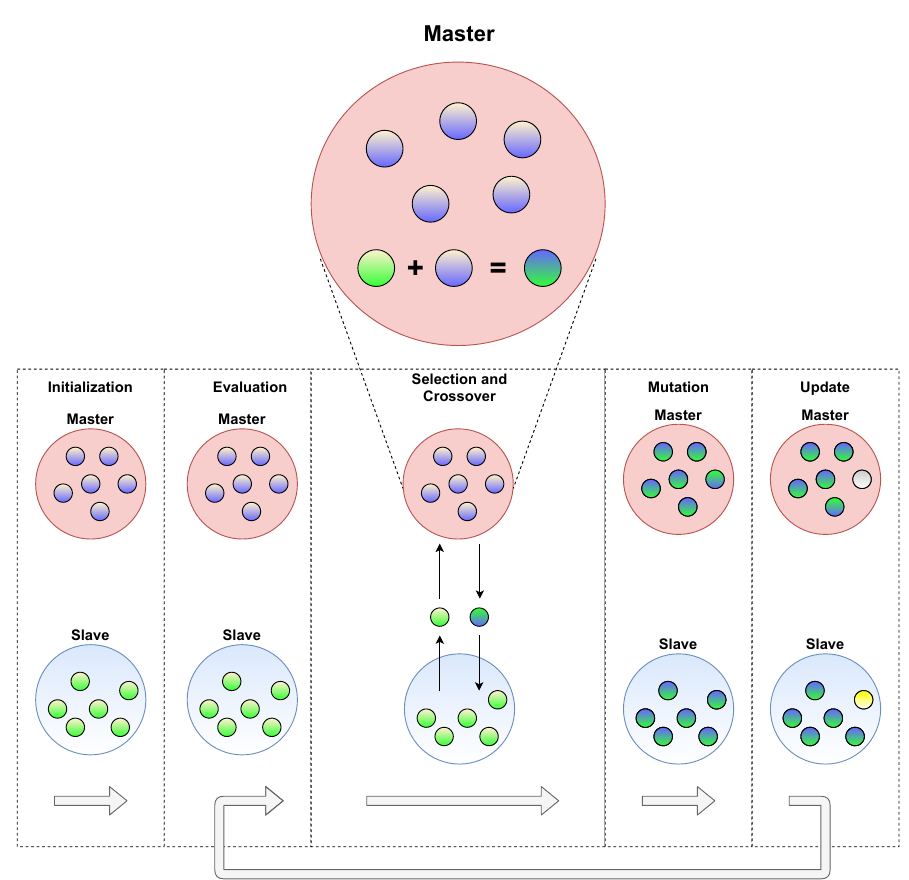
Figure 5. Master-slave distributed genetic algorithm (GA) model proposed by this work for distributed genetic algorithms showing that the selection and crossover are executed by the master node after collecting individuals from the